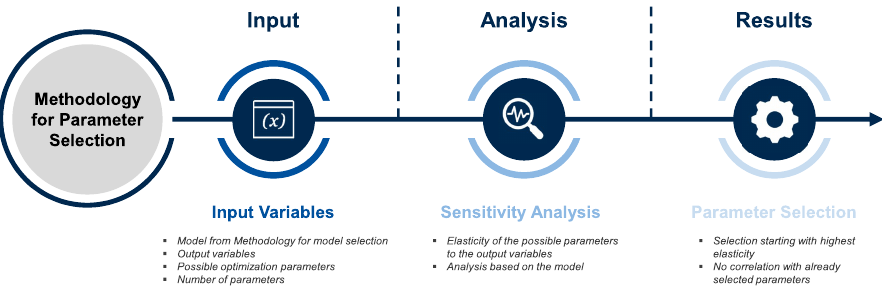
Figure 9. Process of the approach for the parameter